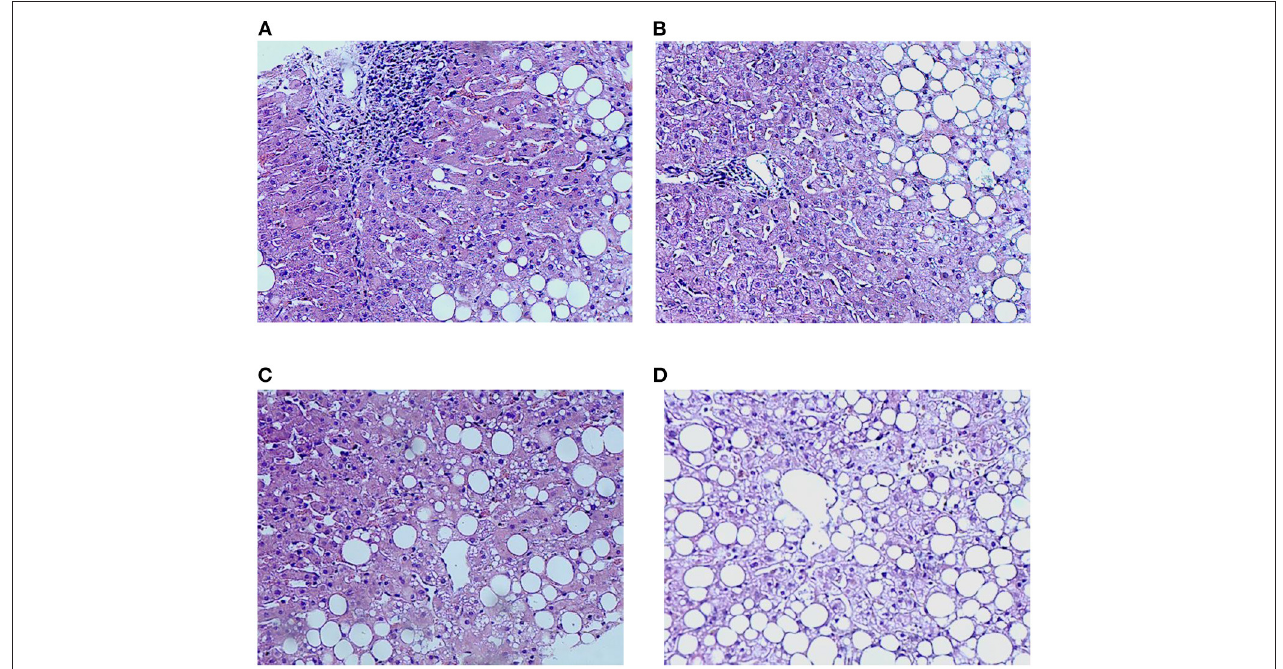
FIGURE 2 | Characteristics of inflammation and lipidosis in the liver between the HBV-RI group and the non-HBV-RI group. HBV-RI group, HBV-related inflammation group; non-HBV-RI group, non-HBV-related inflammation group. (A) Pathological characteristics of inflammation in the HBV-related inflammation group (HE 200 × ); (B) pathological characteristics of inflammation in the non-HBV-related inflammation group (HE 200 × ): no obvious inflammation and no boundary plate damage in the portal area (HE 200 × ); (C) lipidosis characteristics of the HBV-related inflammation group (HE 200 × ); (D) lipids in the non-HBV-related inflammation group (HE 200 ×